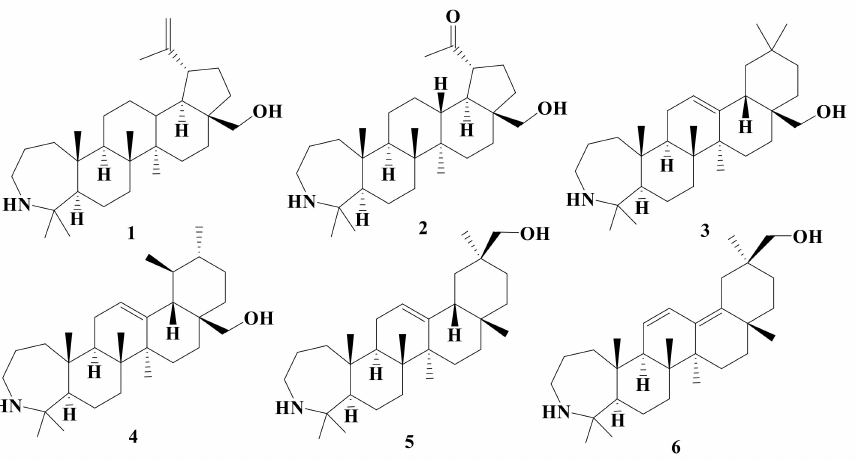
Figure 1. Azepanotriterpenic alcohols: Azepanobetulin 1 , azepanomessagenin 2 , azepanoerythrodiol 3 , azepanouvaol 4 , azepano-glycyrrhetols 5 and 6